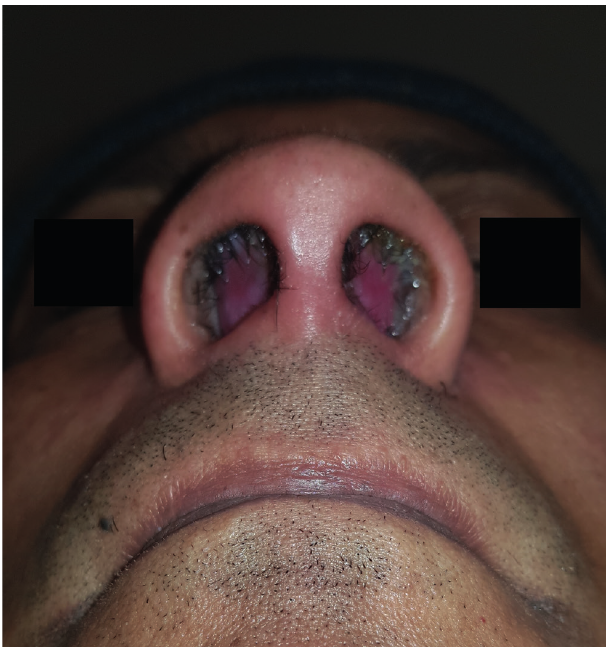
Figure 1. Anterior bilateral nasal septal swelling causing bilateral nasal obstruction.